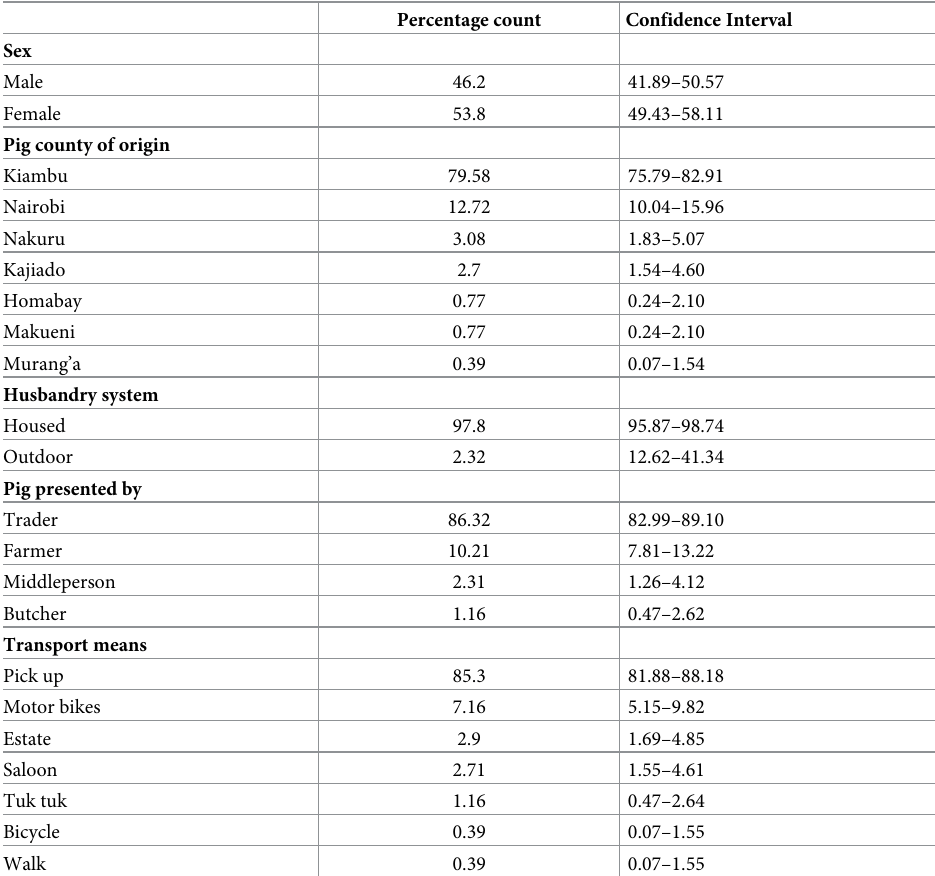
Table 2. Pig data as reported by those presenting pig to